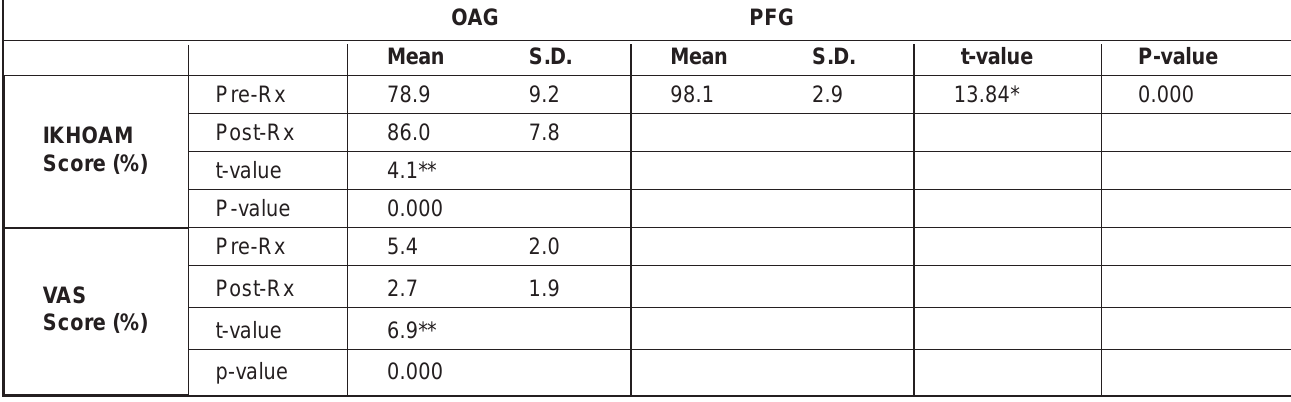
Table 1: t-test for IKHOAM and VAS